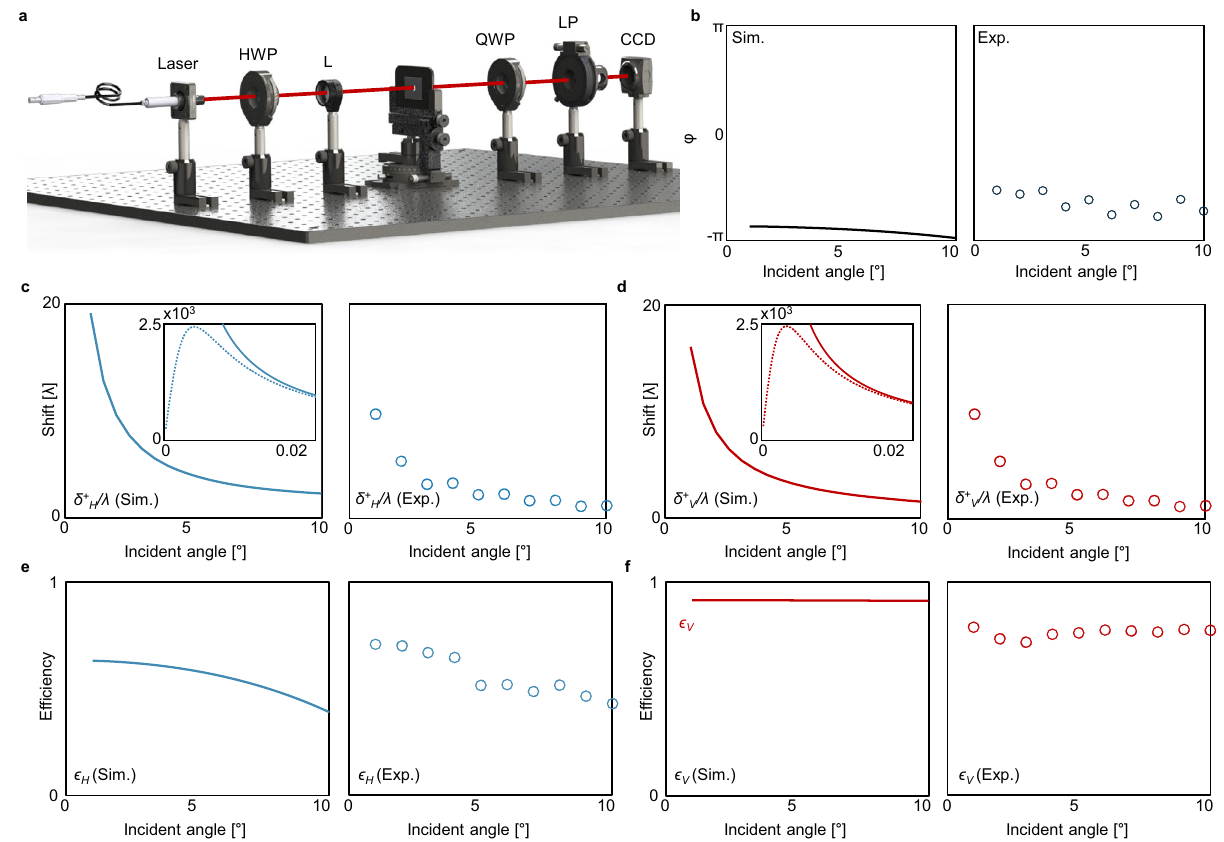
Fig. 4 Measurement of the SHEL at 800 nm. a Schematic of Stokes polarimetry set-up. HWP: half-wave plate, L: lens, QWP: quarter-wave plate, LP: linear polarizer, CCD: charge-coupled device camera. b Phase difference between t s and t p , c δ þ H = λ , d δ þ V = λ , e ϵ H , and f ϵ V . Curve: simulated, markers: measured. Insets in c , d show the magni fi ed view for near-normal incidence where the analytic formula (solid) given by Eq. (1) deviates from the exact shifts (dashed) due to the breakdown of the assumption, i.e., ð 2 π w = λ Þ 2 (cid:3) cot 2 θ i . Error bars of the measured data are not shown because they are all smaller than the